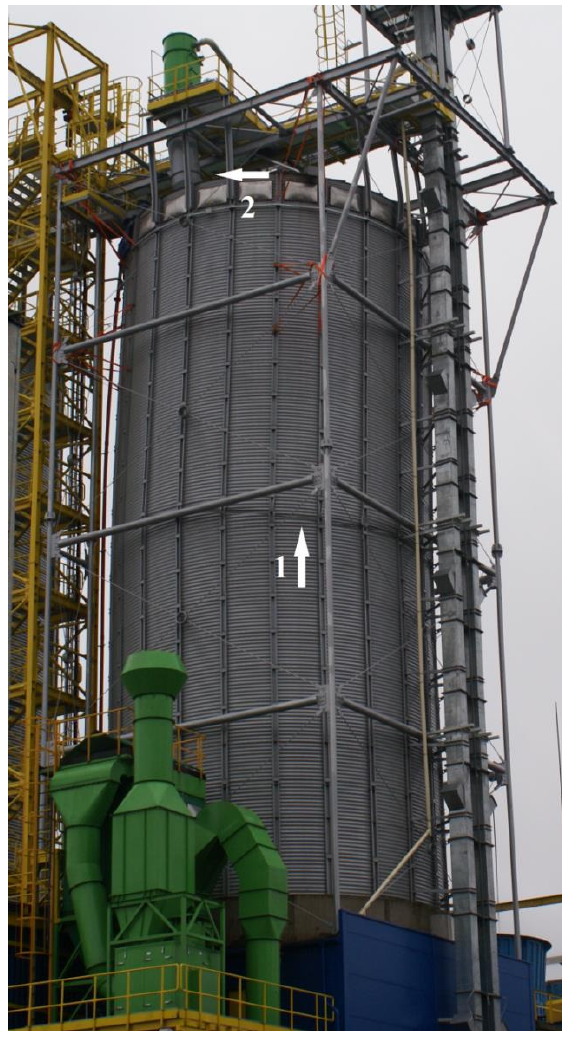
Fig. 1. Silo after failure: 1 – one-sided deformation of tens cm wide band of ribbed shell; 2 – displaced upper part of cylinder and broken joint between shell and gallery (tilting of silo) In the meridional direction the load is carried by vertical stringers with a top hat cross section, made from cold bent profiles. In total there are 22 stringers shifted by an angle of 16.36 ° along the chamber’s